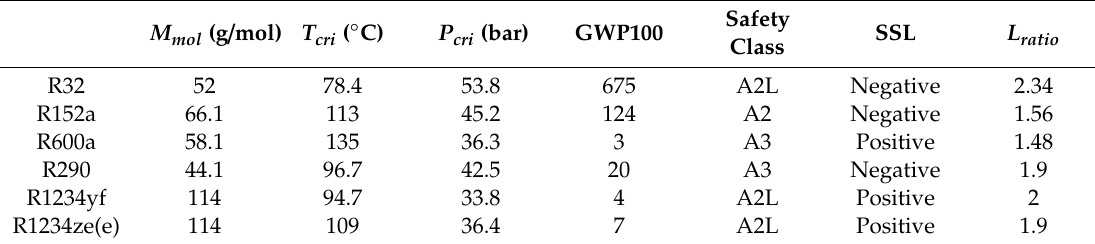
Table 1. Key properties of selected refrigerants.